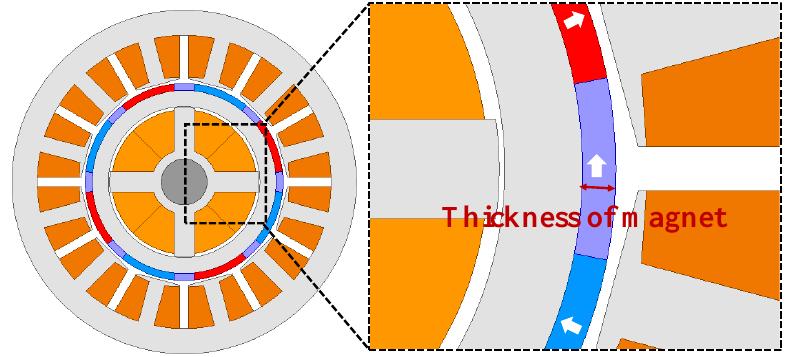
10 of 17 Figure 13. Bearing force and ripple according to tangential PM angle. ( a ) ( b ) Figure 14. Rotor magnetic flux density plot: Tangential PM angle: ( a ) 2° mechanical; ( b ) 22° me- chanical. In Figure 15, the rotor parameters for the magnet thickness are shown. The torque and torque ripples with respect to the tangential PM angle are shown in Figure 16. As the thickness of the PM increases, the magnetic flux of the PM increases; thus, the torque in- creases linearly. The torque ripple continued to increase as the thickness of the PM in- creased. The bearing force and bearing force ripple according to the PM thickness are shown in Figure 17. The magnitude of the bearing force decreased linearly as the thickness